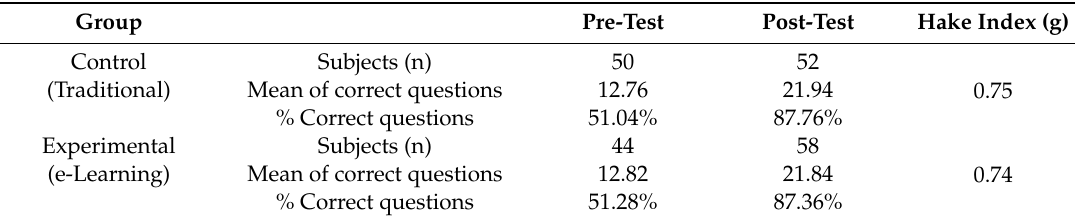
Table 6. Hake Index values.